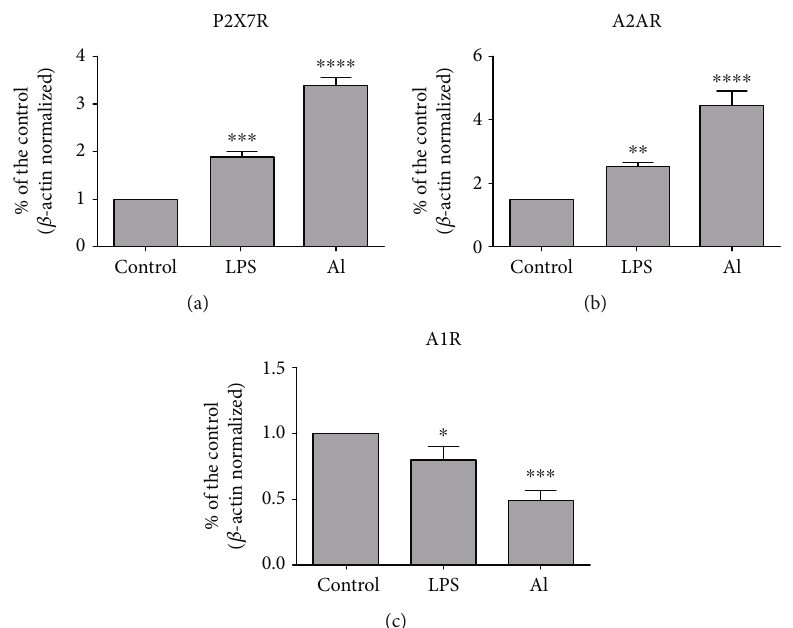
Figure 3: Gene expression of purinoceptors by RT-qPCR analysis of microglial cells treated with LPS (1 μ g/mL) and AlCl 96h. Al =aluminum; LPS=lipopolysaccharide. Values are expressed as mean ± SD ( n = 3 ) of the relative concentration compared to the control group. ∗ Statistical signi fi cance in comparison to the control group. ∗ p < 0 : 05 , ∗∗ p < 0 : 01 , ∗∗∗ p < 0 : 001 , and ∗∗∗∗ p < 0 : 001 . One-way ANOVA followed by Tukey ’ s post hoc test.